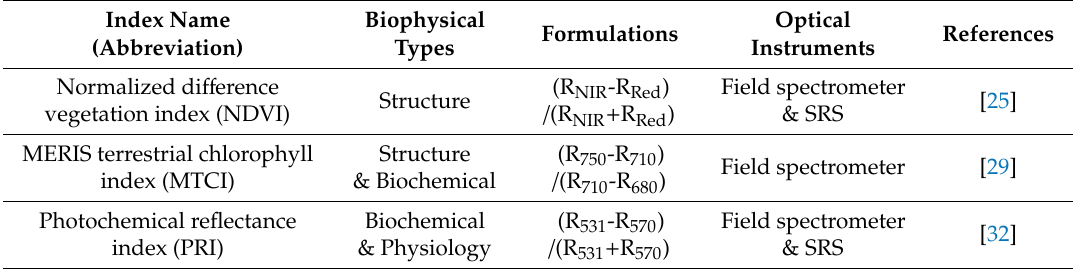
Table 2. Spectral reflectance-based vegetation